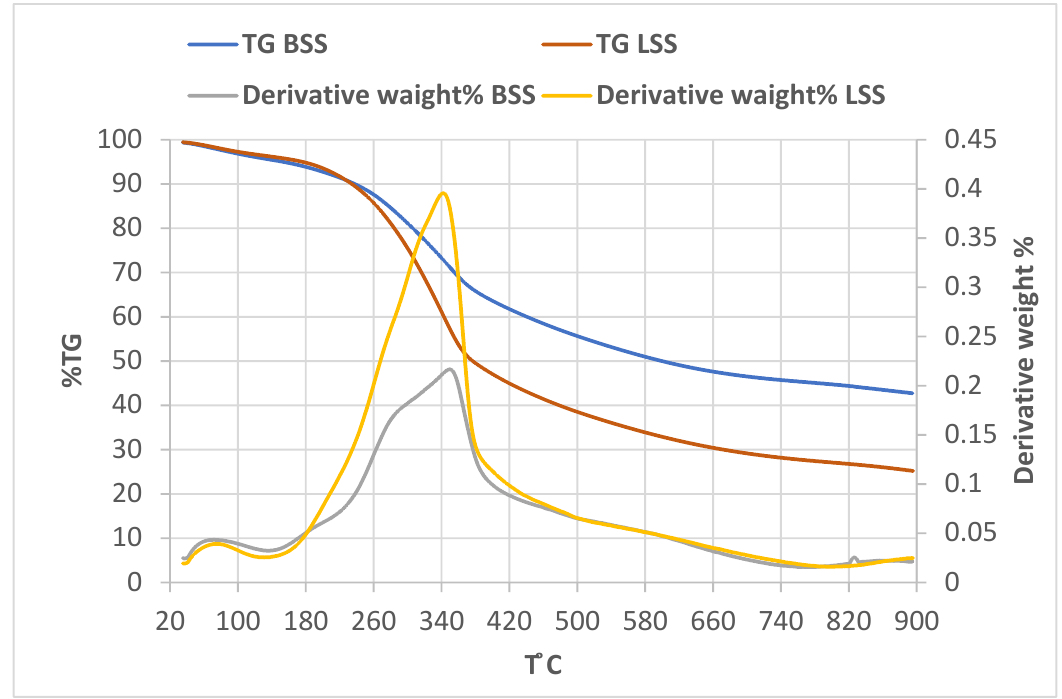
Figure 7. Thermogravimetric analysis of BSS and LSS.